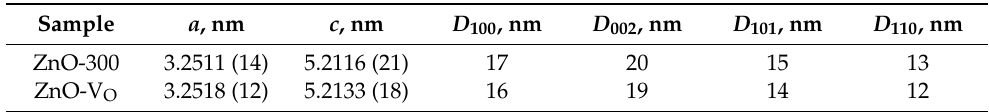
Table 1. Crystal lattice parameters and average size of crystal regions in different crystallographic directions of ZnO-300 and ZnO-V O